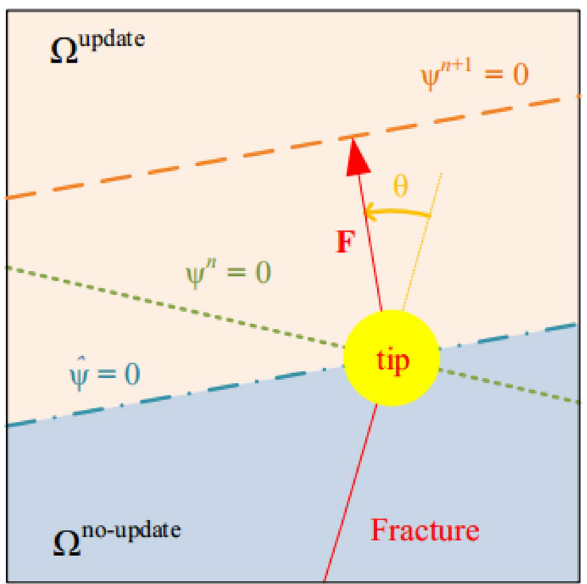
Fig. 5 Identifying the nodes for which LSF is to be updated (Youn